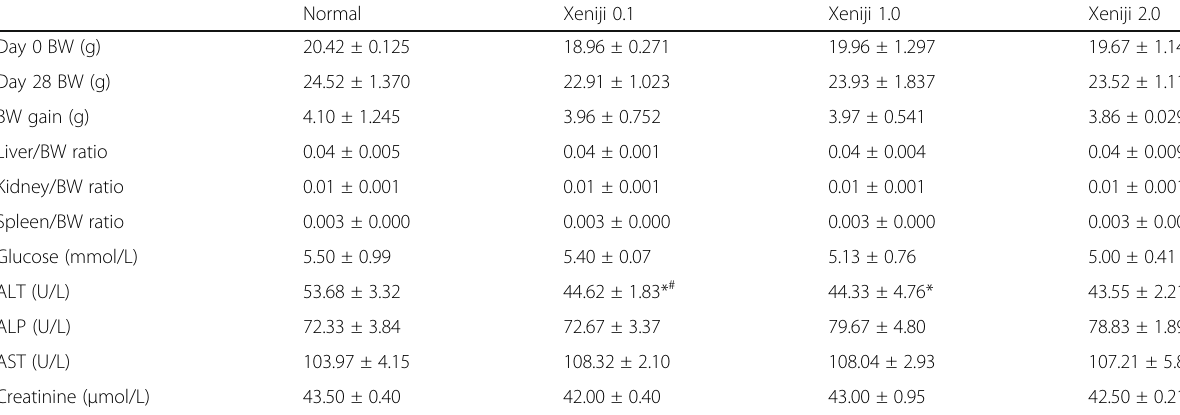
Table 6 Body weight, organ weight and serum liver enzyme profile of normal and 5 g/kg body weight of Xeniji treated mice for 30 days of subchronic toxicity study